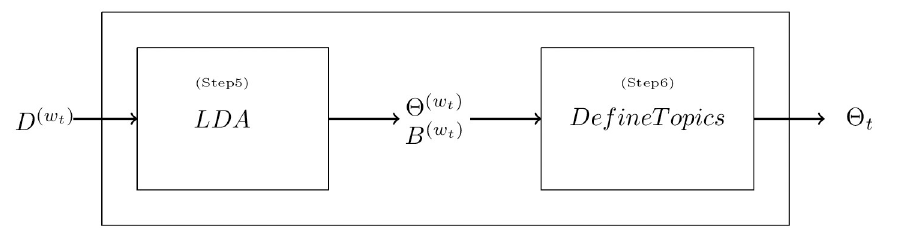
Fig 3. The workflow for rolling LDA